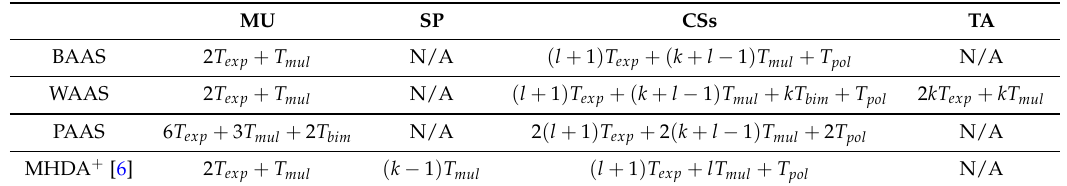
Table 4. Comparison of the computational overhead. BAAS, basic average aggregation scheme; WAAS, weighted average aggregation scheme; PAAS, privacy-enhanced aggregation scheme; MU, mobile user; CS, cloud server; TA, trusted authority.